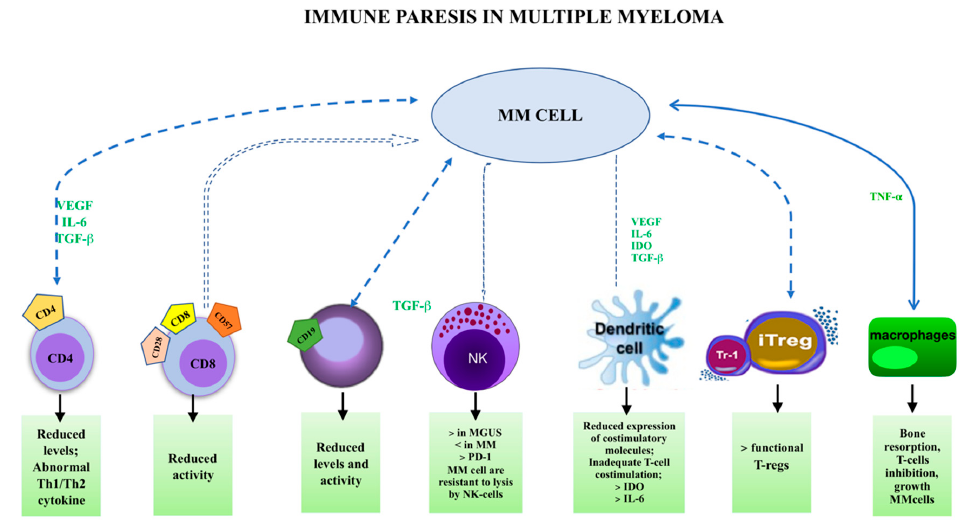
Figure 1. Immune cells involved in multiple myeloma (MM) pathogenesis. The more the arrows are thicker, the most the pathways seems being involved.